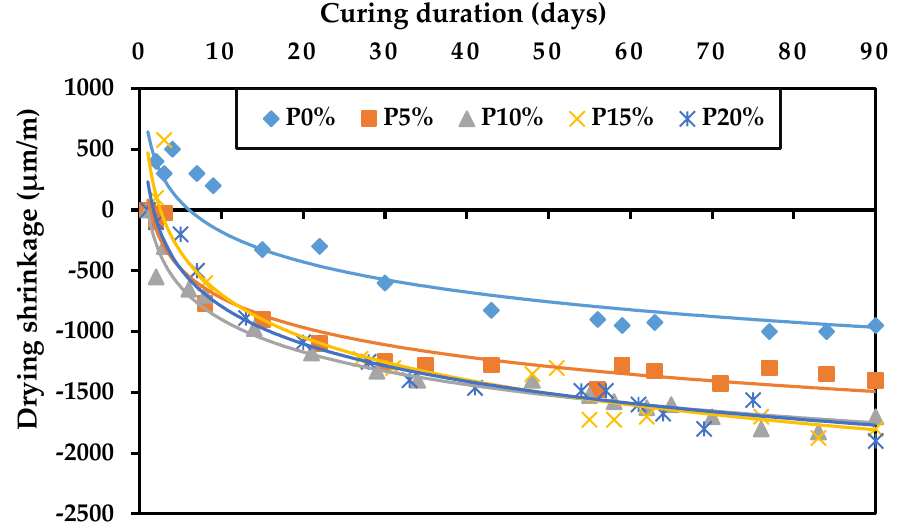
Figure 7. Drying shrinkage of pastes with different percentages of LF over 90 days.